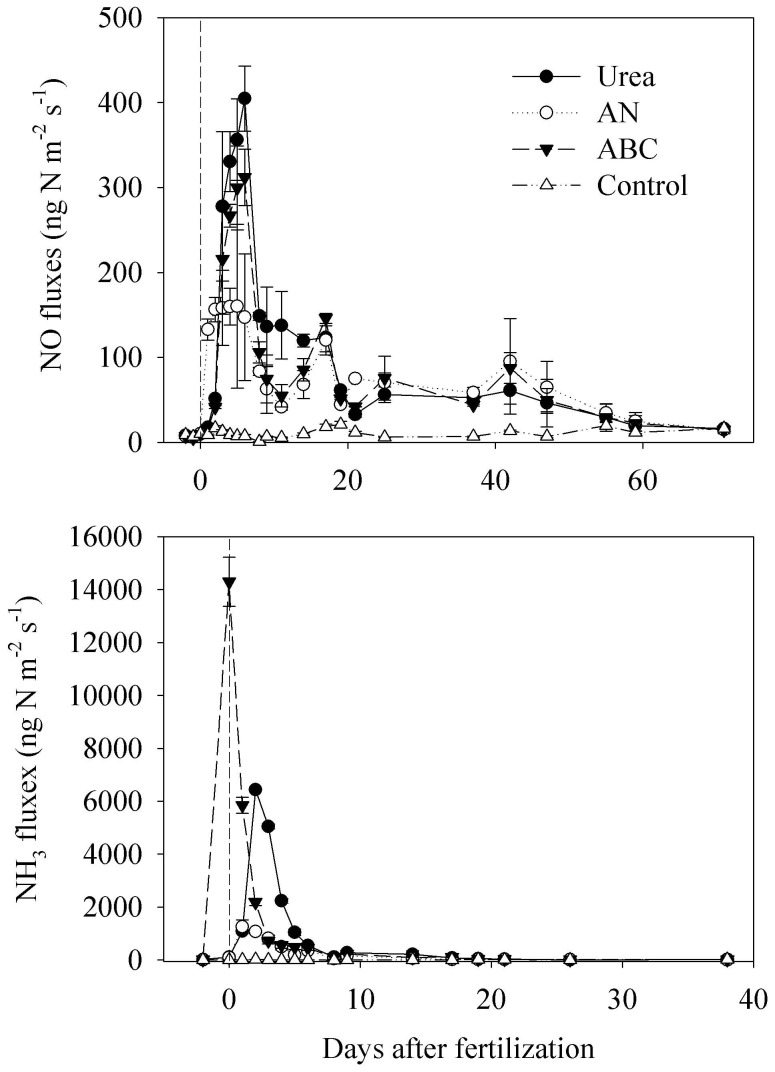
NO and NH3 fluxes during the sampling period.Each value is the mean of three replicates, and error bars represent standard errors. Vertical dash line indicates the day when fertilizers were applied.